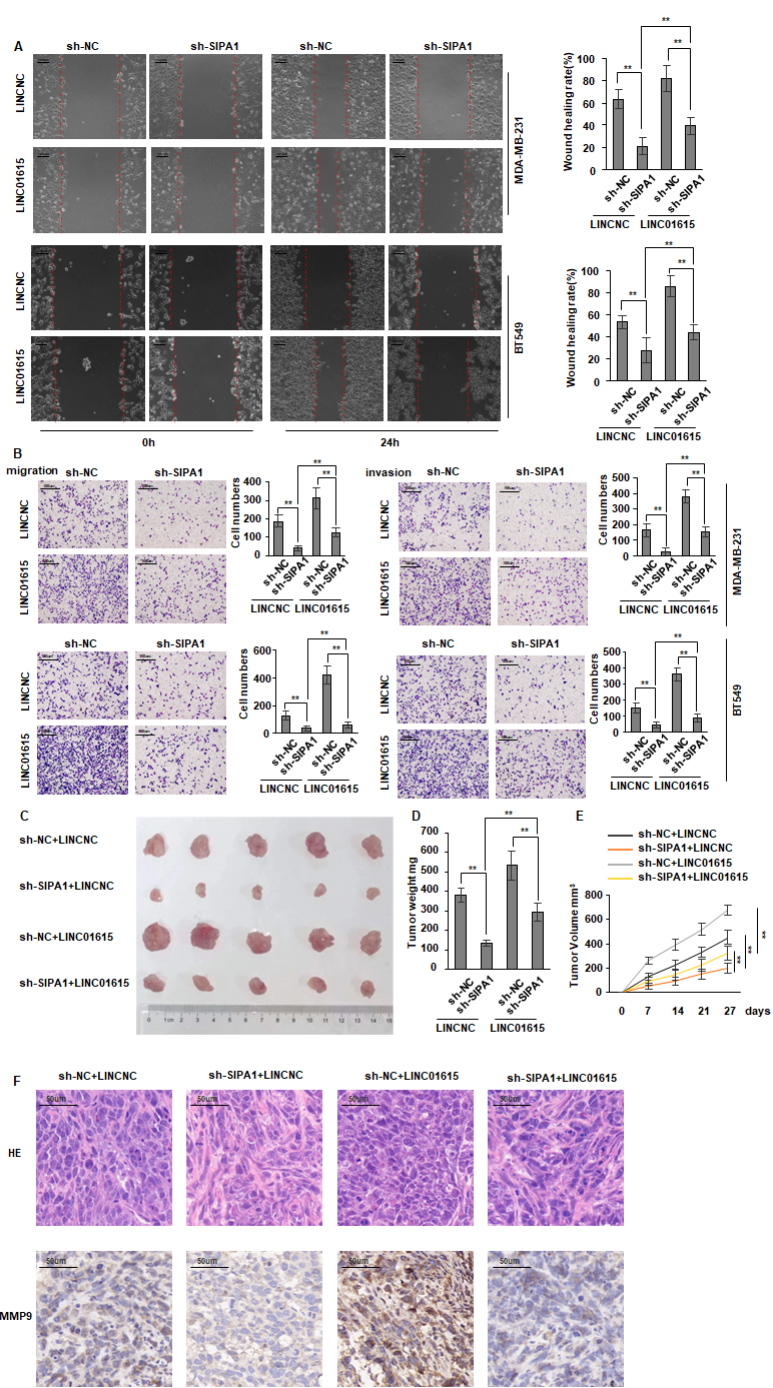
Figure 4. Overexpression of LINC01615 could counteract the inhibition of SIPA1 knockdown. ( A , B ) BT549 and MDA-MB-231 cells were transfected with control LINC, LINC01615, shRNA, and SIPA1 shRNA as indicated. ( A ) Scratch wound assays and ( B ) Transwell migration and Matrigel invasion assays were performed 24 h after transfection. ( C , D ) Subcutaneous xenografts of MDA-MB-231 cells infected with LINC01615 lentivirus and SIPA1 knockdown lentivirus (shSIPA1). ( C ) Images of the tumors at autopsy from nude mice are presented. ( D , E ) Tumor volume and weight of xenografted tumors were measured. ( F ) Representative H&E-stained sections and Immunohistochemical analysis of the tumor tissues isolated from mice. Data represent the means ± SD. ** p <